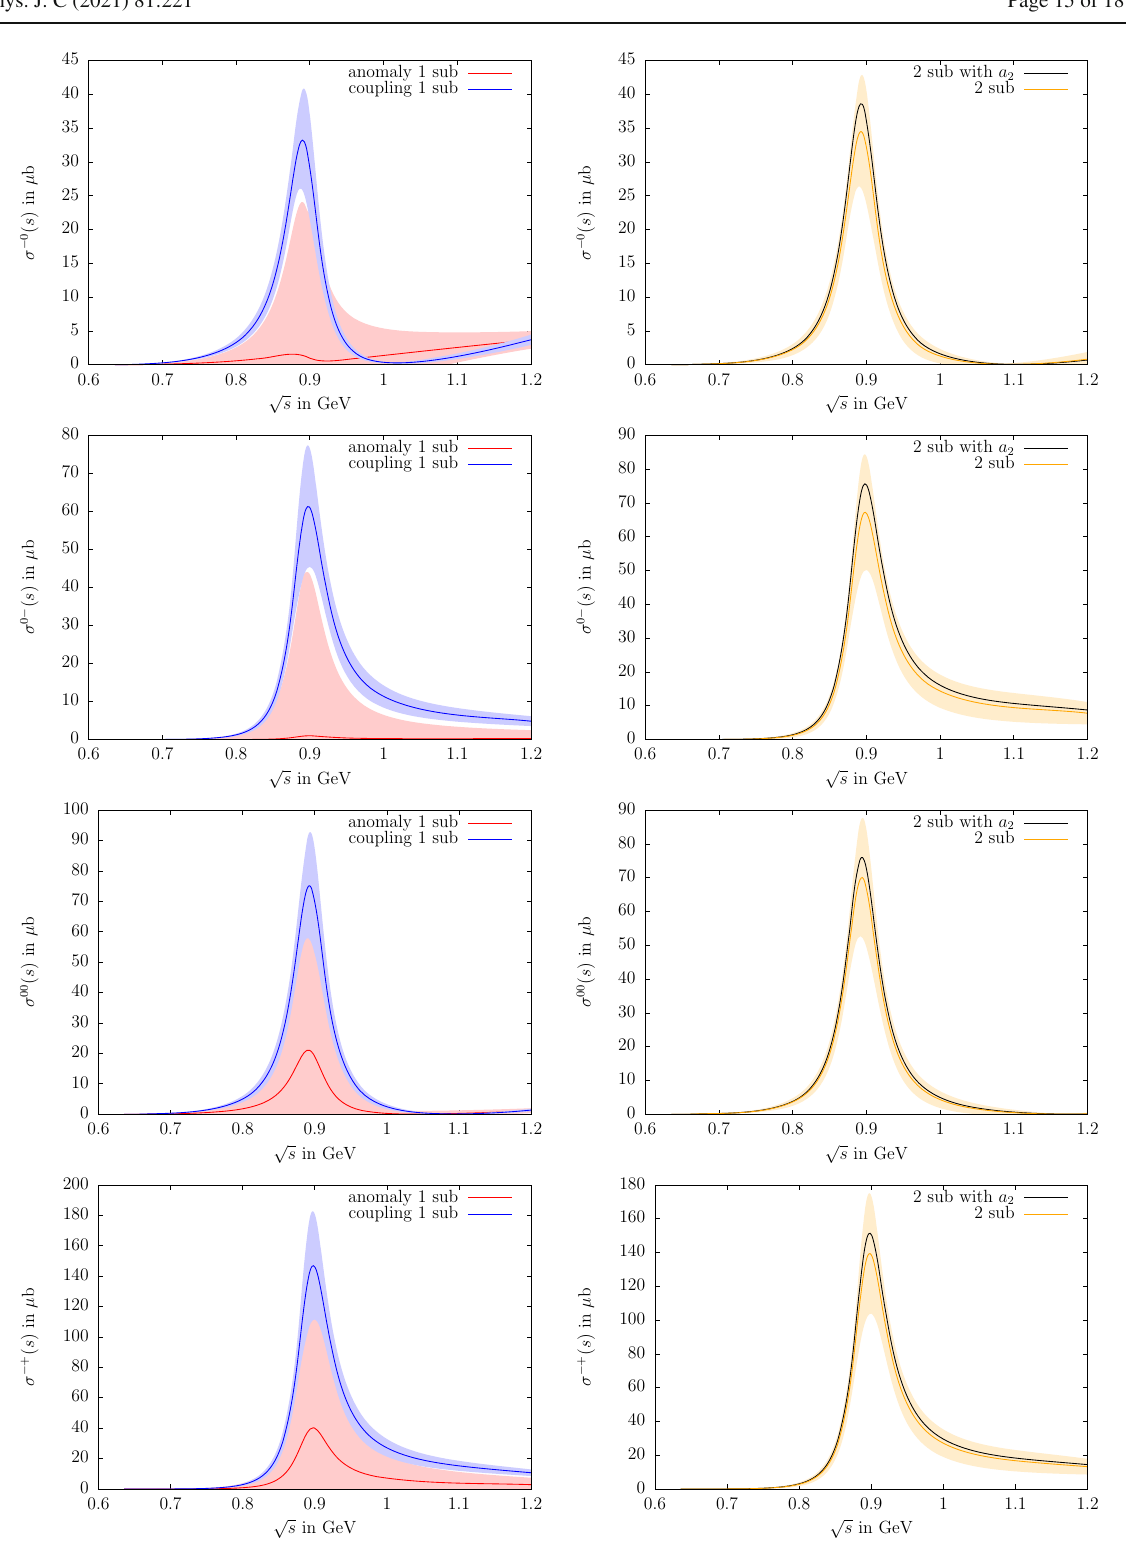
panels:twicesubtractedscheme,matchedtoanomalyandradiativecou- plings simultaneously, with and without the a 2 contribution. The error bands correspond the propagated error of the real and imaginary